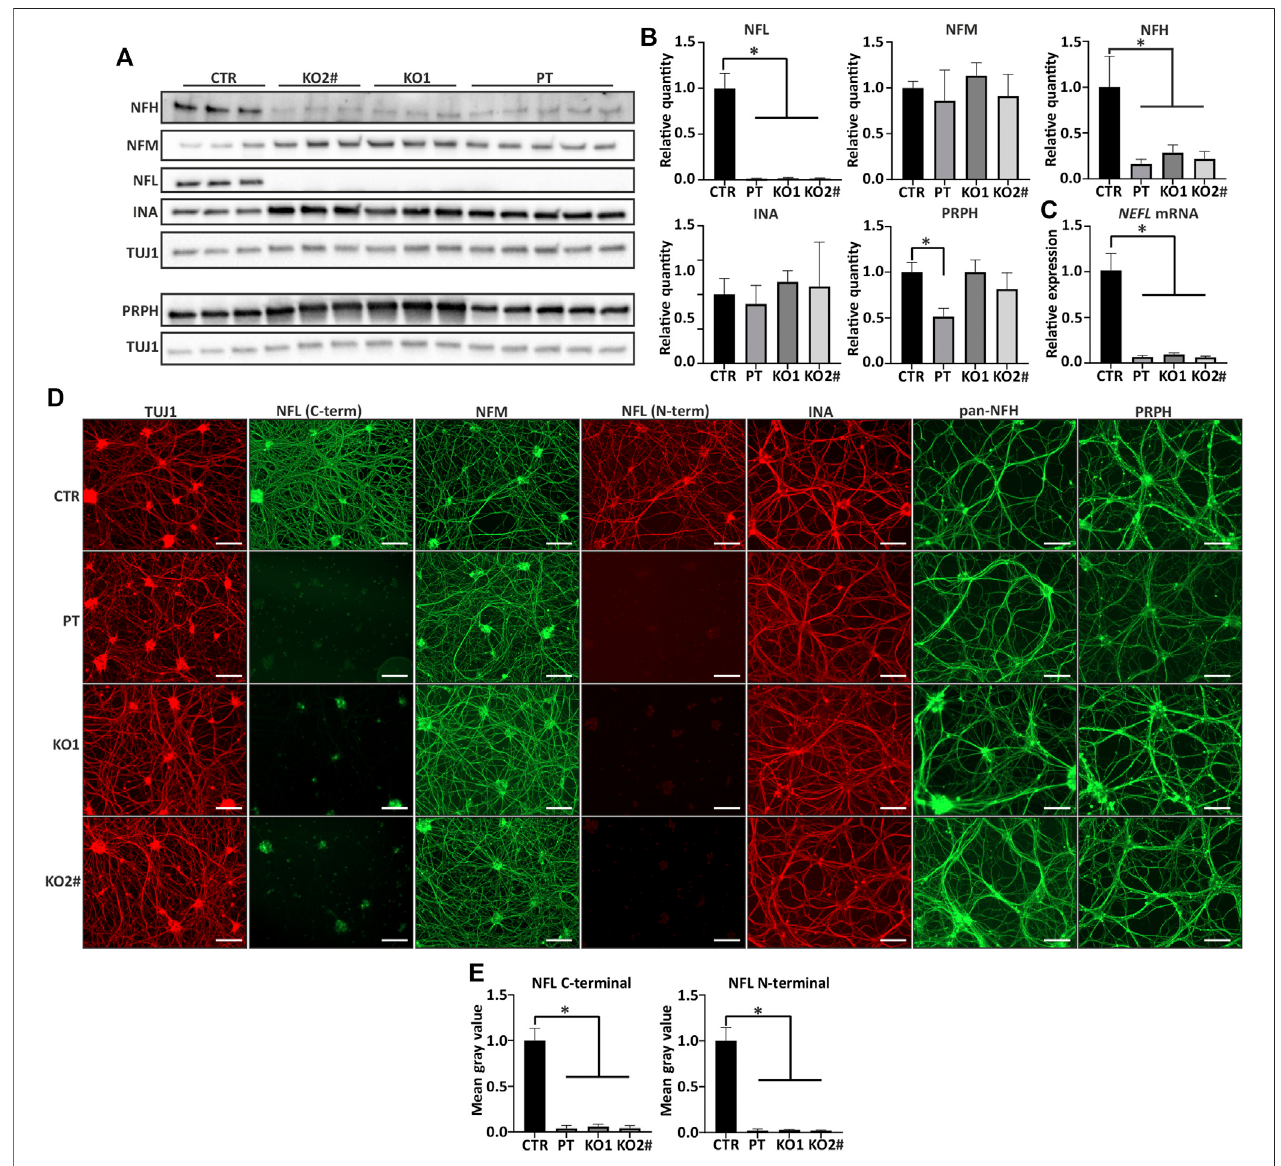
FIGURE 2 | Other fi lament proteins are expressed in NEFL KO and patient iPSC-MN. (A) NEFL KO motor neurons express other neuro fi lament proteins. Representative immunoblot showing presence of all other tested neuro fi lament proteins in NELF KO and PT Day 35 motor neurons. NFL = NFL antibody (Sigma) and TUJ1 = TUBB3 antibody. (B) Quanti fi cation of A. Full-length NFL is indistinguishable from background ( p < .0001) and NFH is reduced in KO and patient motor neurons ( p < .0001). NFM or INA levels are not changed, and PRPH is reduced only in PT ( p < .0001). n = 6-7 from two independent differentiations. Signal intensity normalizedtoTUBB3proteinsignal. (C) RT-qPCRshowsreduction( p < .0001)in NEFL mRNAexpression.Theresidualamountof NEFL mRNAisapproximately10%of control levels. Expression levels are normalized to TUBB3 . n = 6-7 from two independent differentiations. (D) All differentiated motor neurons (days 35 – 39) grow elaborate neurite networks positive for TUBB3 (TUJ1), NFM, INA, NFH, and PRPH. Scale bar 100 µm. (E) Quanti fi cation of NFL from immunocytochemistry shows reduction in NFL signal with C- and N-terminal antibodies ( p < .0001). n = 4 from two independent differentiations. Data shown in all as mean with SD. * p < .0001. One- way ANOVA followed with Dunnett ’ s multiple comparison post hoc test vs. CTR. # indicates abnormal karyotype.